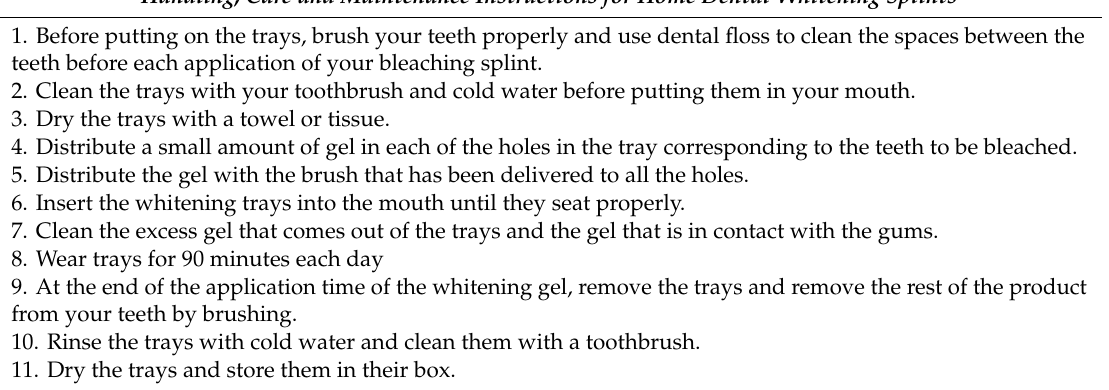
Table 1. Instructions for the patient for the application of home